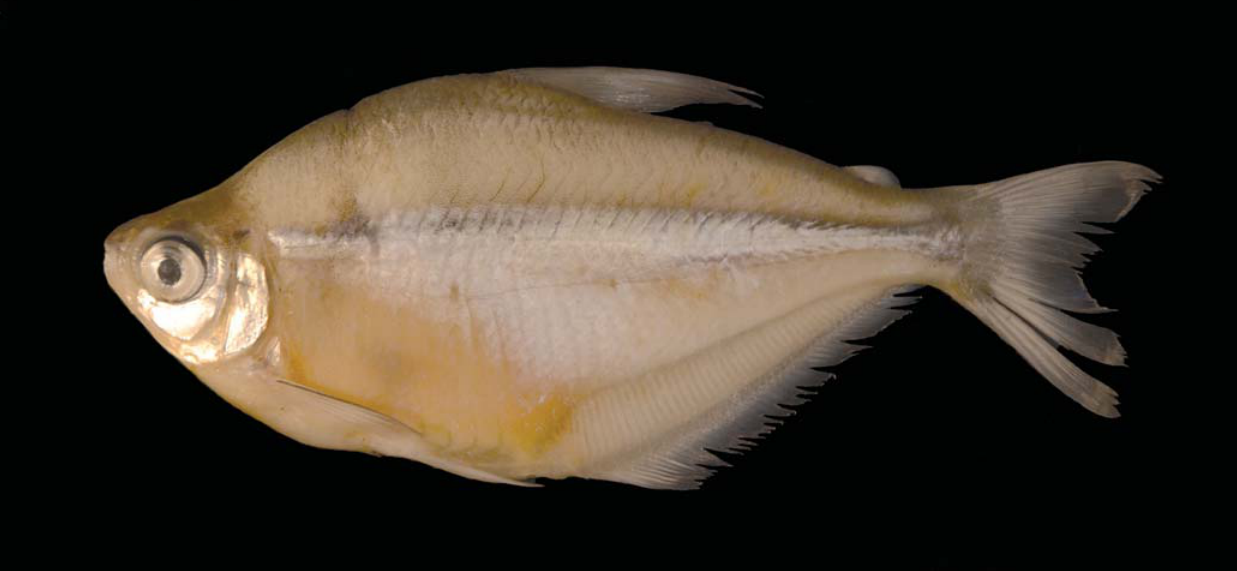
Fig. 4. Astyanax erythropterus (adult), MACN-ict 9448, 88.4 mm SL, Argentina, Provincia de Corrientes, ciudad de Yahapé, río